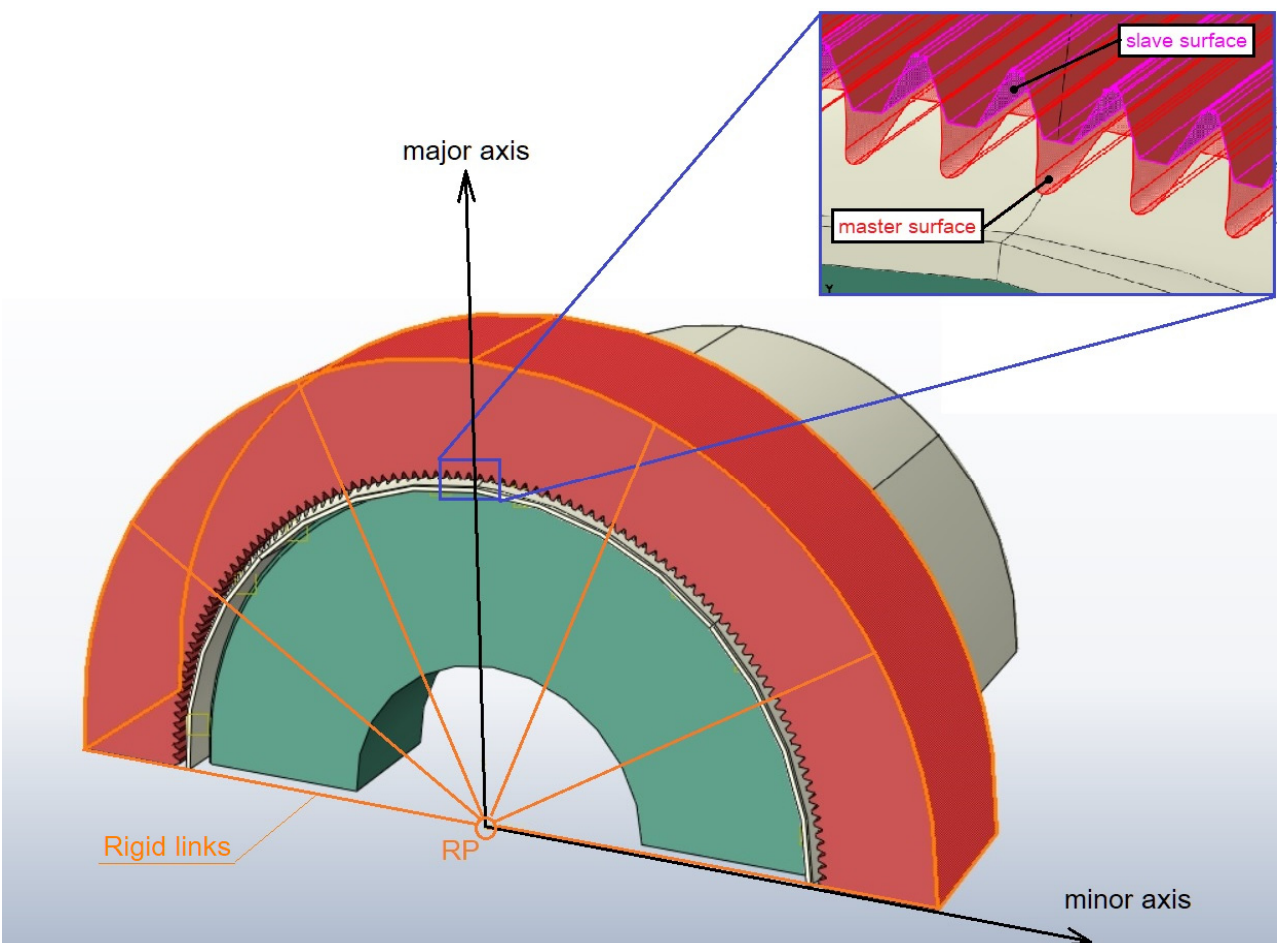
Figure 3. General view of model of harmonic drive.